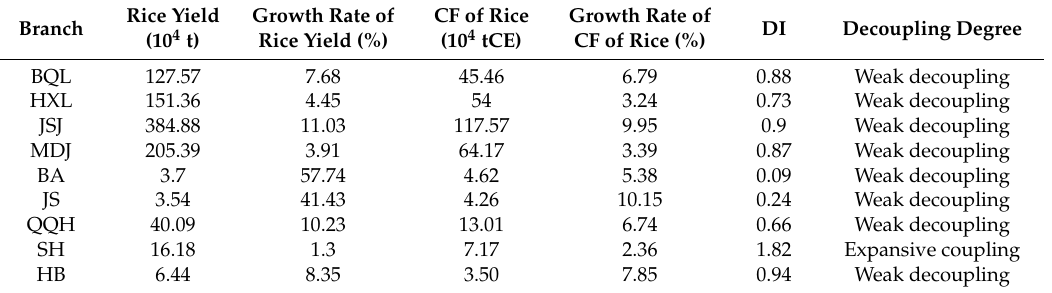
Table 6. Decoupling GHG emissions from rice production at the branch scale of the HLRA (average of the years